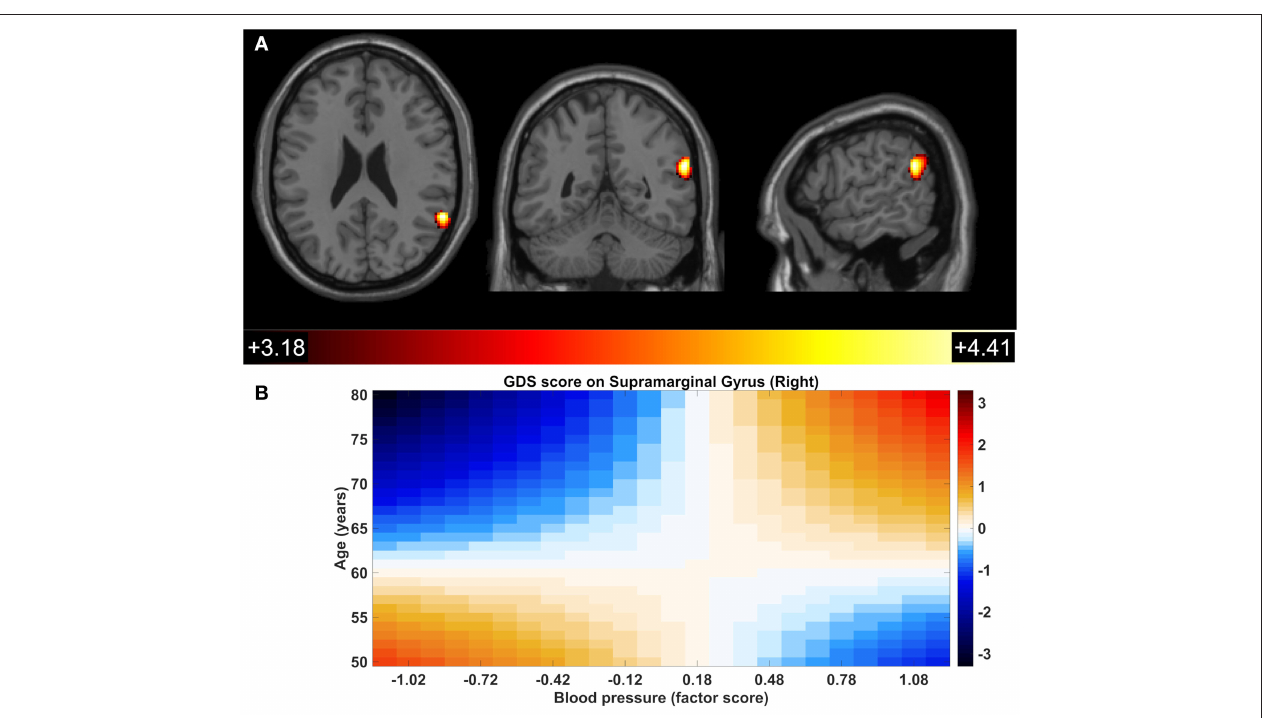
FIGURE 6 | Significant age x GDS x blood pressure interaction within the default mode network in the right supramarginal gyrus. Colors represent standardized coefficients ( β ). DMN regions presenting significant interactions of age x GDS x blood pressure (A) . Association of the GDS score with the FC of the right supramarginal gyrus across age and blood pressure score; colors represent standardized coefficients ( β ) (B)